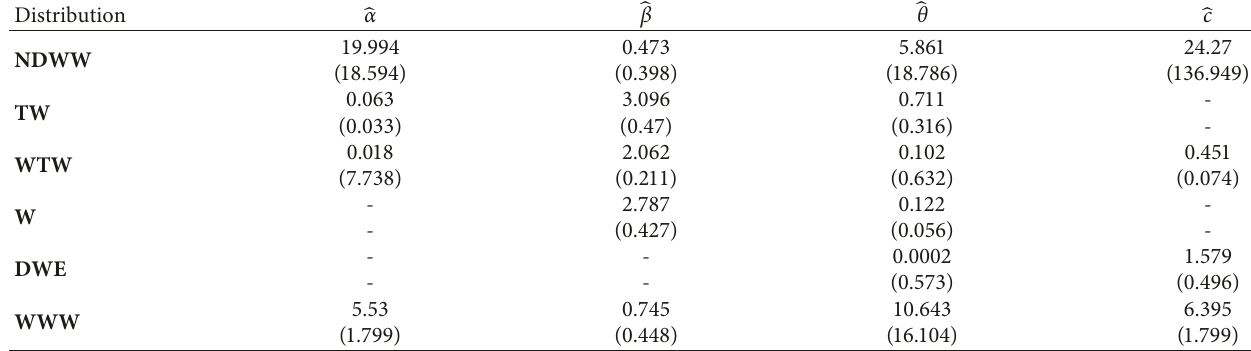
Table 8: MLEs and (SErs) for the dataset